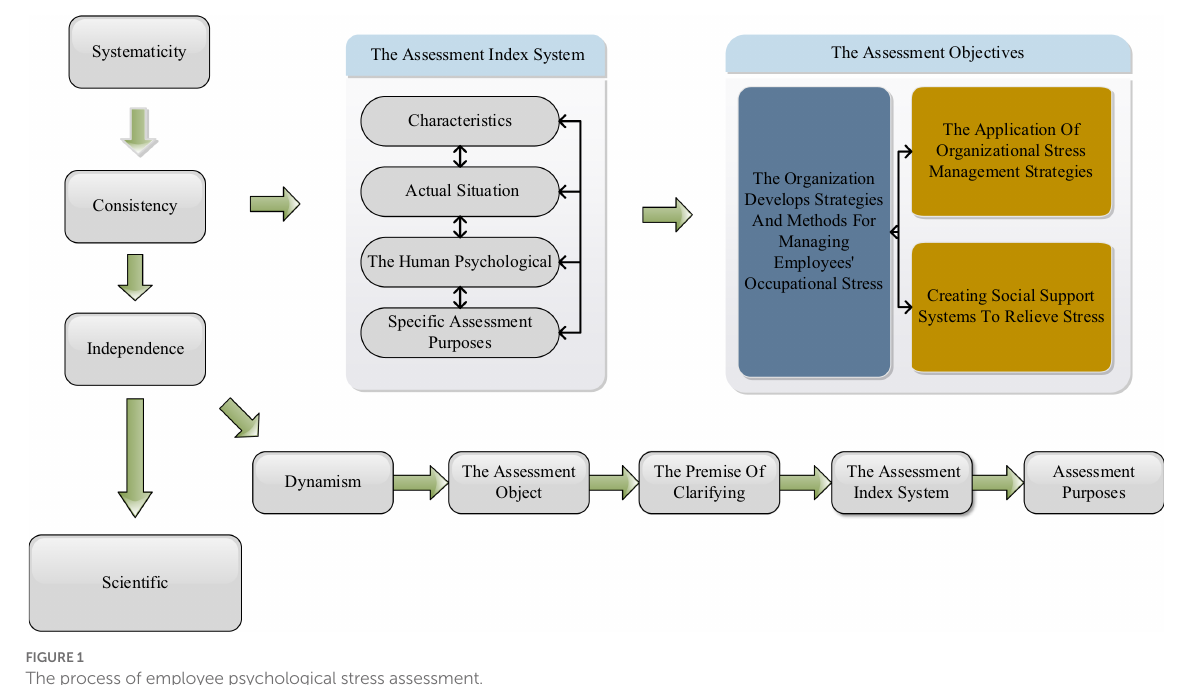
FIGURE 1 The process of employee psychological stress